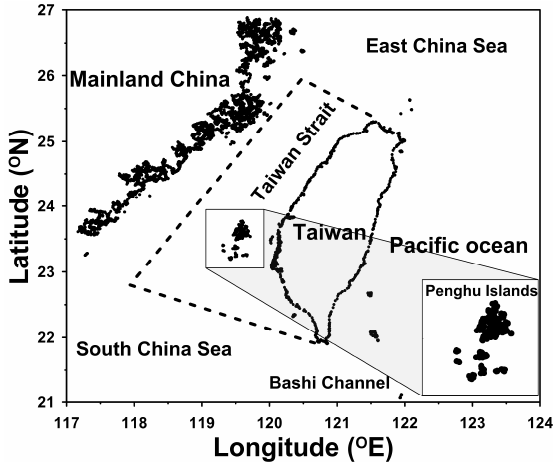
Figure 1. Map of the study area shown in the dashed line box.